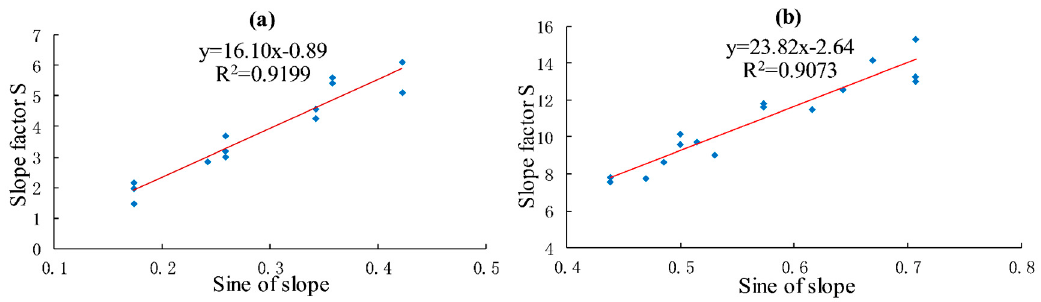
Figure 4. Relationship between the sine of slope and the slope factor: ( a ) slopes between 10° and 25°; and ( b ) slopes above 25°.